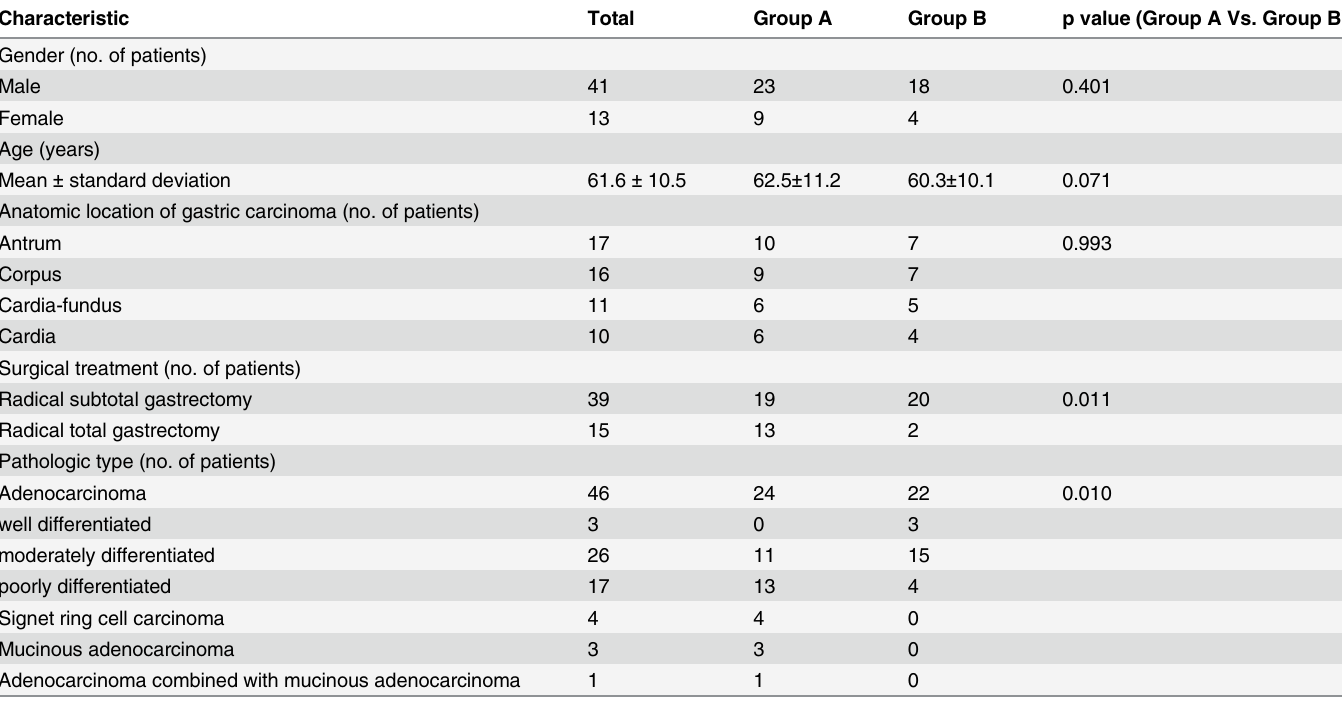
Table 1. Clinical and demographic characteristics of the 54